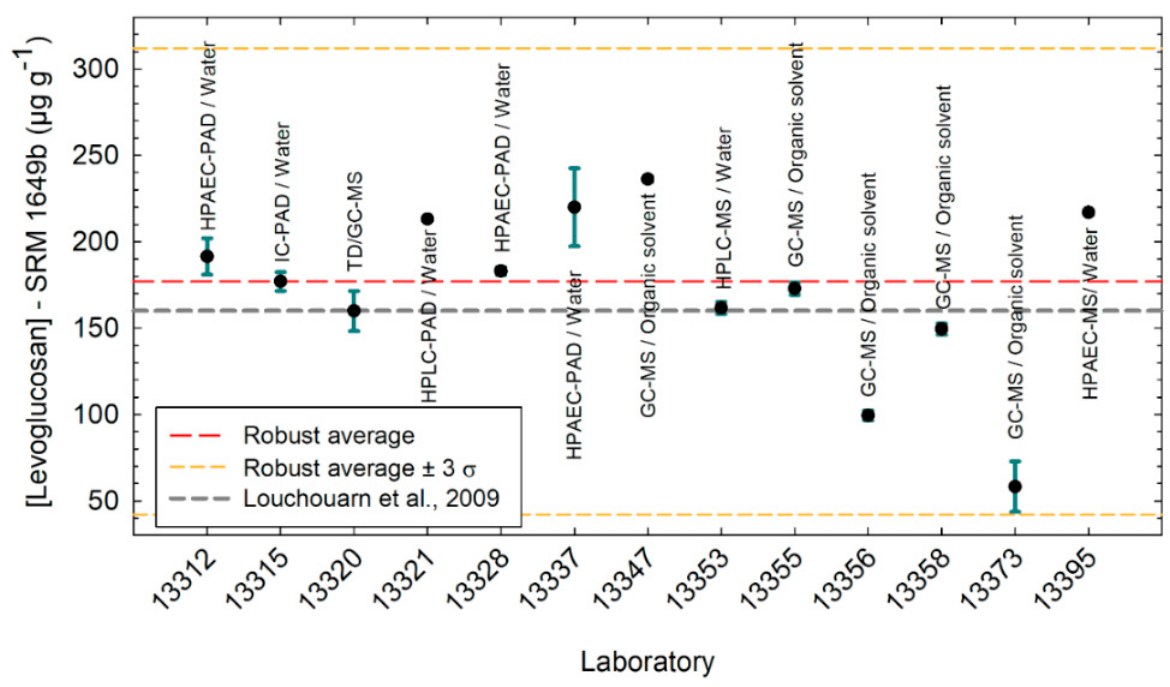
Figure 2. Distribution graph of the concentration values of levoglucosan obtained for the analysis of the NIST SRM 1649b (urban dust) amongst 13 participants (arbitrary identification numbers) and various analytical methods.